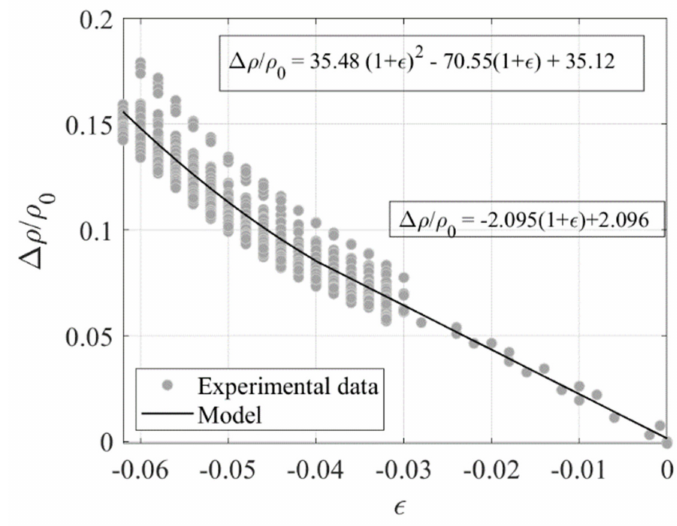
Figure 25. Variation of resistivity ratio vs. compression strain.